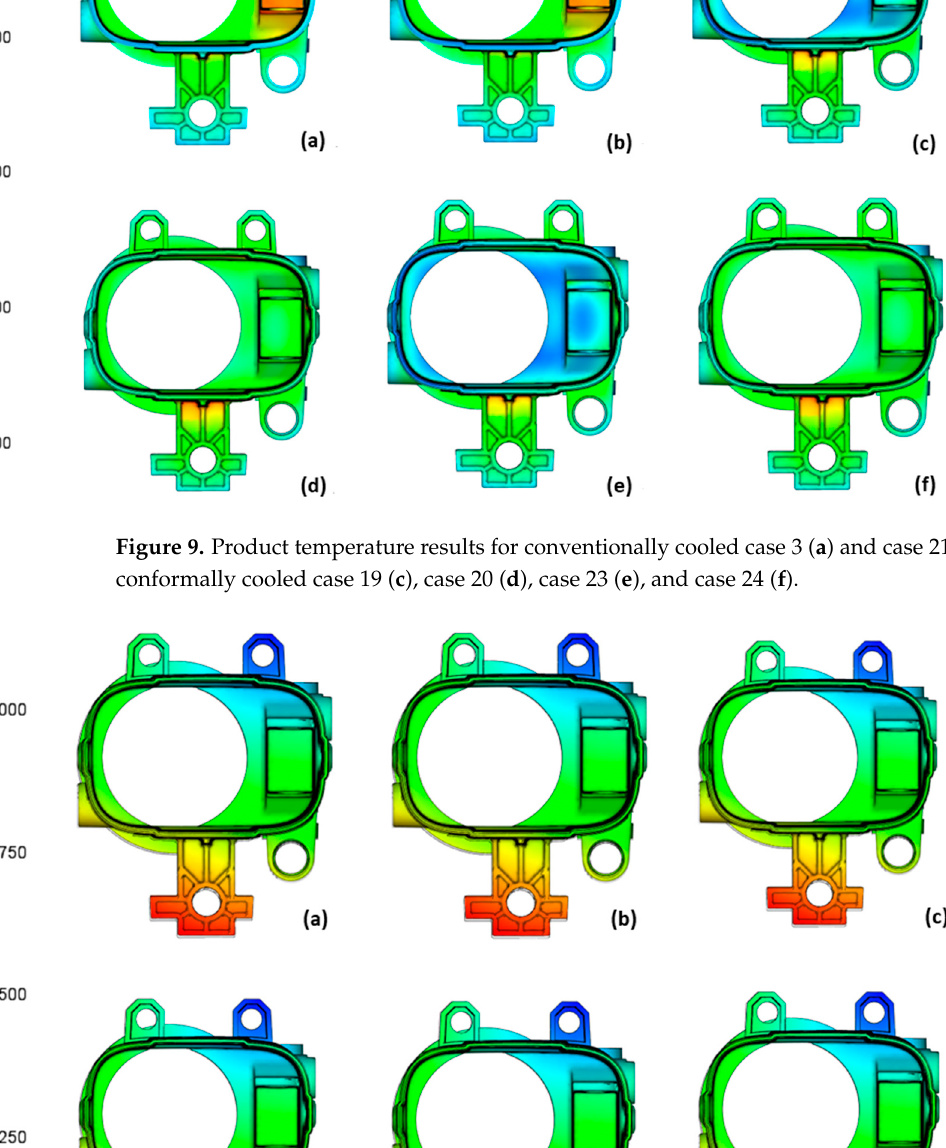
Figure 10. Product deformation results for conventionally cooled case 3 ( a ) and case 21 ( b ) and for the conformally cooled case 19 ( c ), case 20 ( d ), case 23 ( e ), and case 24 ( f ).